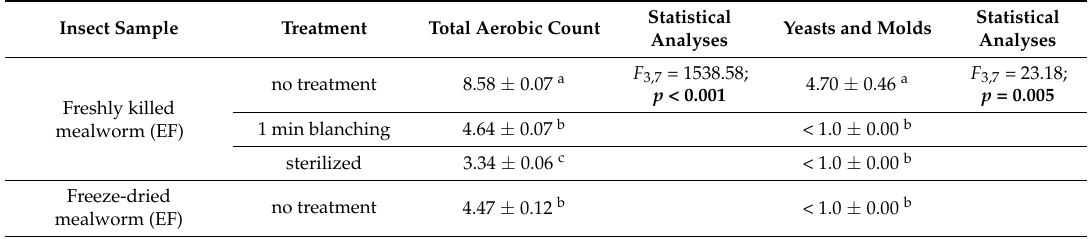
Table 1. Effect of different treatments on the total aerobic and yeast and molds counts (log cfu/g) of different edible insect species found in Belgium ( n = 3; DRC = from Democratic Republic of Congo; EF = from European farms; statistical analyses = one way ANOVAs for each species with 95% confidence interval; F = F statistic; p : significance level; different letters indicate significant differences between treatments). Freeze-dried and smoked insects were bought already